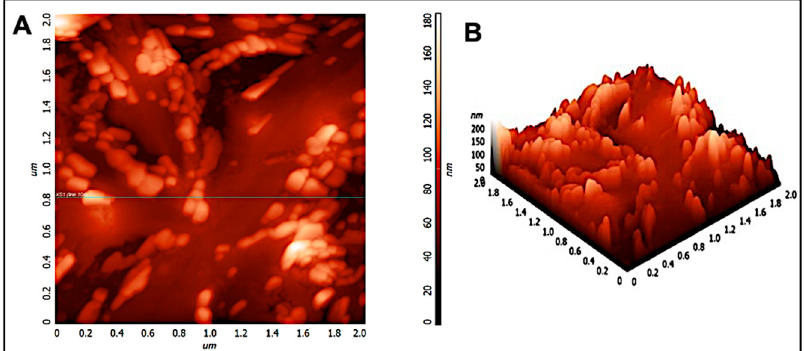
Figure 3. ( A ) 2D and ( B ) 3D atomic force micrograph of chitosan nanoparticles in a 2-micron × 2-micron area.